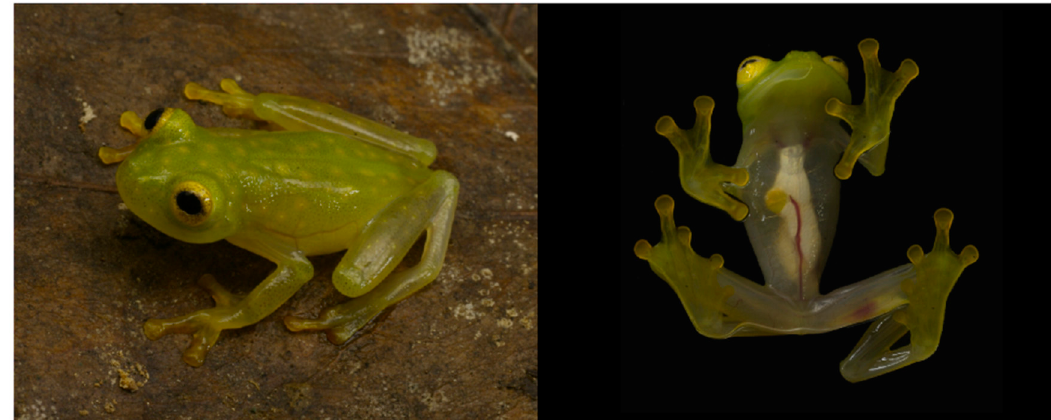
Figure 109. Hyalinobatrachium fleischmanni in life. Ecuador, near Durango, 77 m, QCAZ 32107. Photos by Martín Bustamante. Mart í n